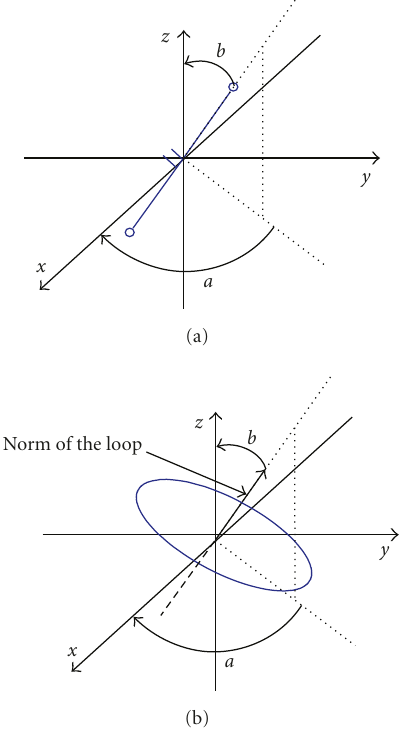
Figure 4: A short dipole or loop with arbitrary